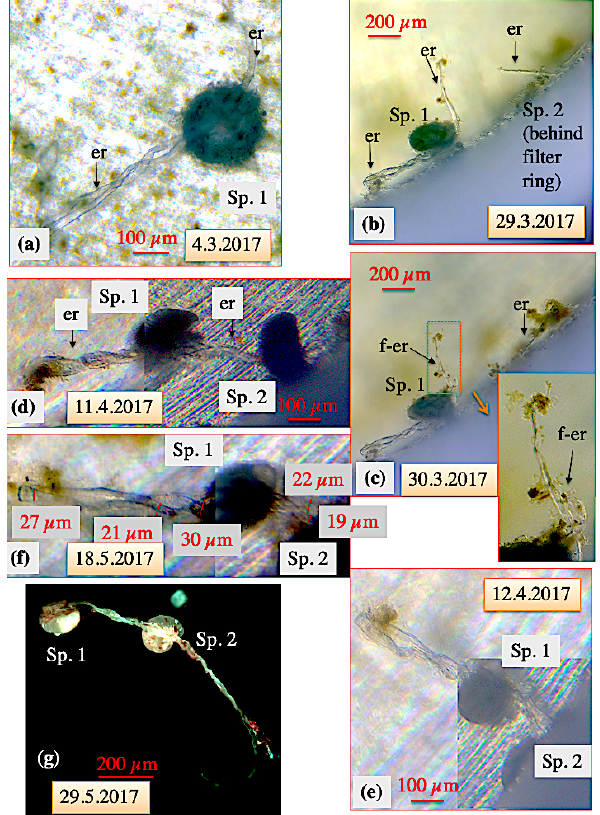
Figure 5. Ectoplasmic roots of C. pachyderma (specimens 1 and 2). (a) Six days after being transferred into the high-pressure aquar- ium, overnight a twisted ectoplasmic root formed on the left and a short simple root on the right side of the test of specimen 1 (Sp. 1). (b) Thereafter, Sp. 1 moved towards the filter ring and finally positioned itself close to an ectoplasmic root of specimen 2 (Sp. 2; situated under the filter ring) on 29 March. (c) The next day, the right-hand ectoplasmic root of specimen 1 started to fray. (d) Sev- eral days later, during a weekend, specimen 2 resurfaced from be- low the filter ring and its left-hand ectoplasmic root was combined with the frayed right-hand root of specimen 1 to a joined twisted or braided ectoplasmic root. (e) The joined braided ectoplasmic root of specimens 1 and 2 (positioned under the filter ring) on 12 April. (f) Thickness measurements of the joined braided ectoplasmic root. (g) Fluorescence picture of the braided ectoplasmic root of Sp. 1 and 2 immediately after termination of the experiment (excitation wave- length 470nm, emission wavelength 490nm). The emitted bright greenish calcein fluorescence of the ectoplasmic root likely indi- cates recent cytoplasmic activity. “er” denotes ectoplasmic root; “f- er” denotes frayed ectoplasmic root. After termination of the ex- periment, gently washing the specimens over a 30µm mesh, and drying the residue, both specimens were still attached via the joined braided ectoplasmic root with a final length of at least 5mm (g)